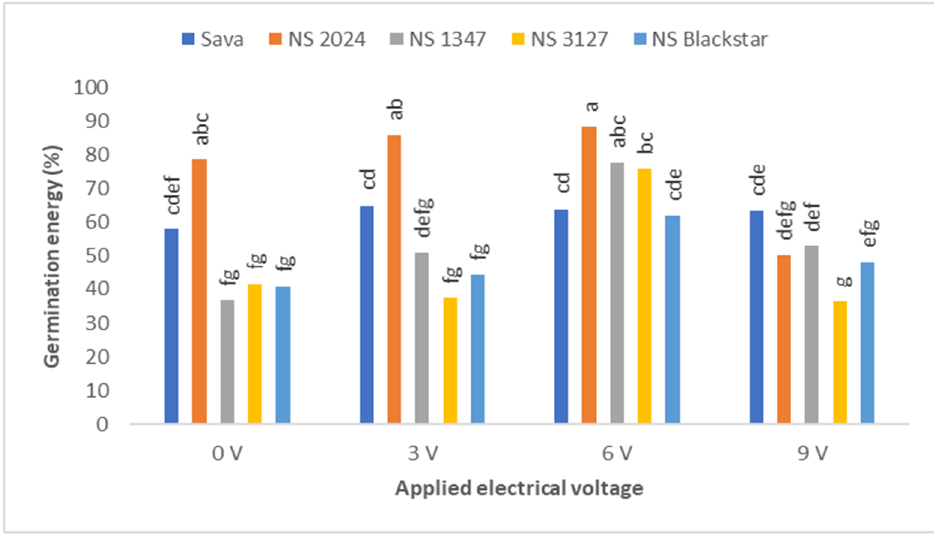
Figure 3. Effect of interaction soybean genotypes × electrostatic field on germination energy (GE). Different letters above the bars represent significant differences at the p ≤ 0.05.